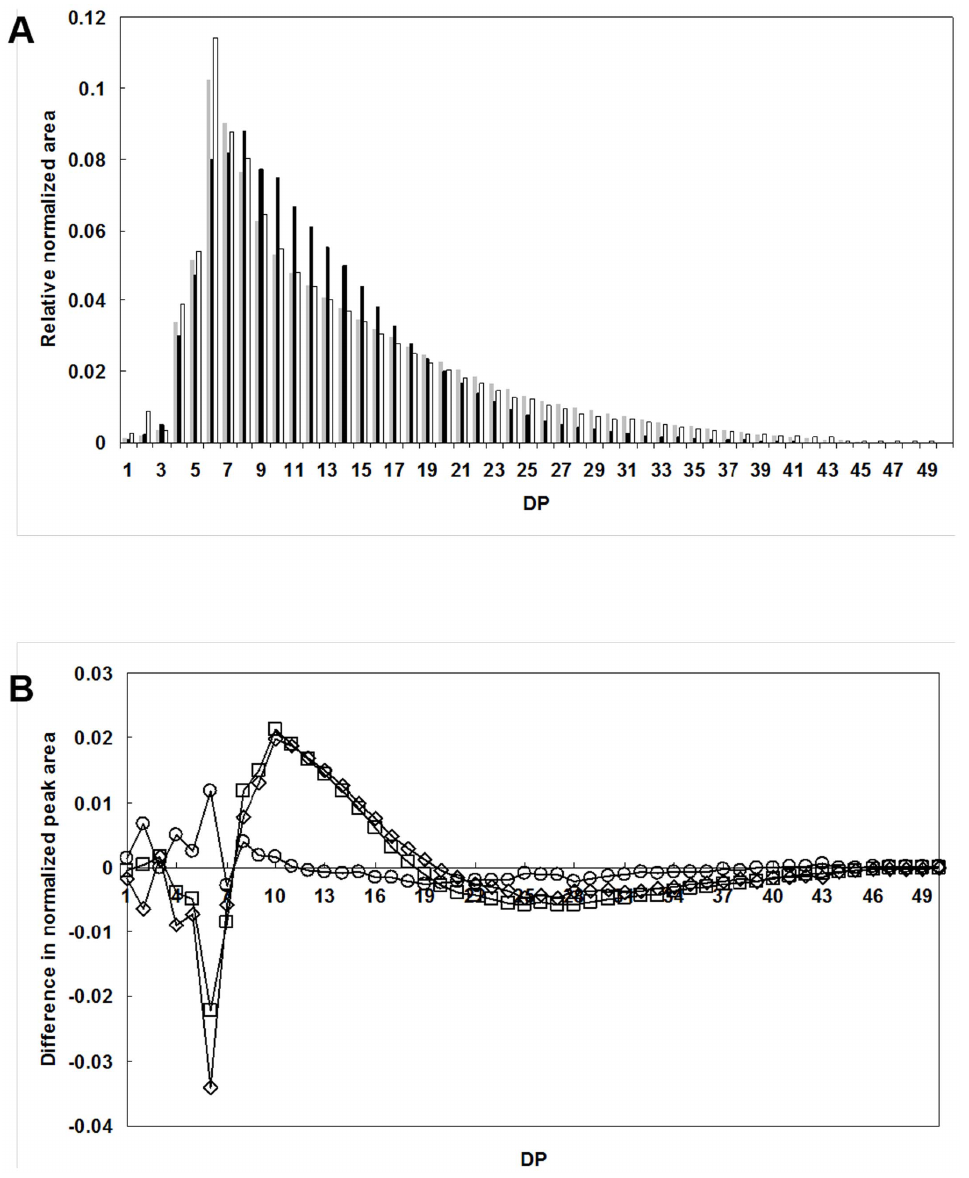
Figure 4. A. Branch chain-length distribution of glycogens from WT ( ), M1 ( & ), and M2 ( % ). Glycogen samples were treated with a debranching enzyme, isoamylase, and the resulting debranched-samples were separated on an HPAEC system. The peak area was calculated and normalized from the chain-profile chromatogram. B. The comparison of difference in the normalized peak area calculated from M1-WT ( % ), M2-WT ( # ), or M1-M2 ( e ).